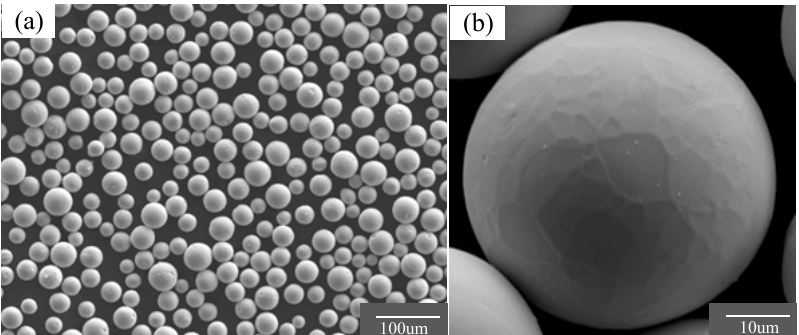
Figure 4. SEM images of spherical molybdenum powder. ( a ) × 200; ( b ) × 1000.